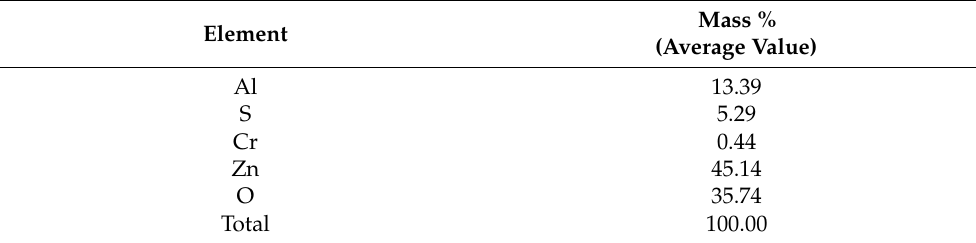
Table 2. Percent mass distribution of the main elements present in the sample considered in Figure 5.